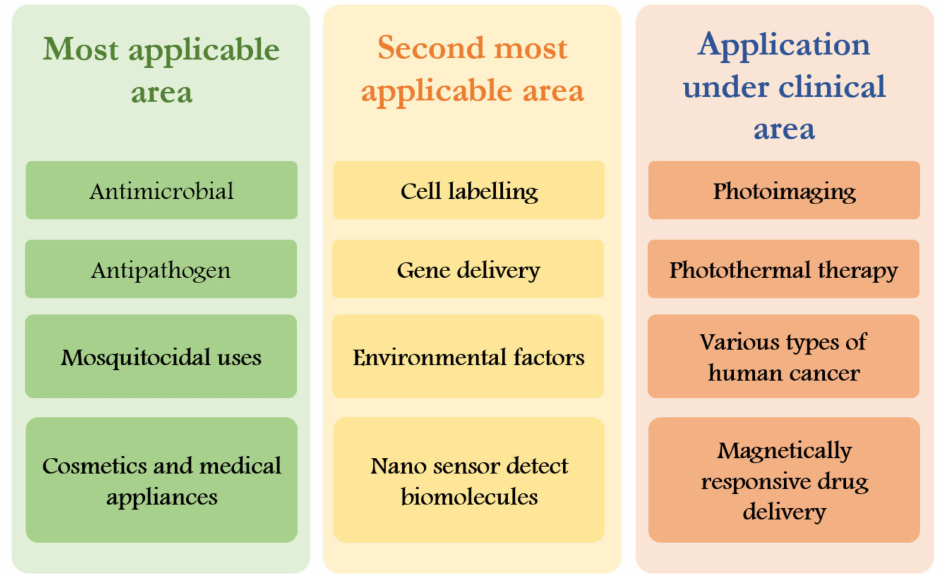
Figure 4. Application of biologically synthesized nanoparticles in various